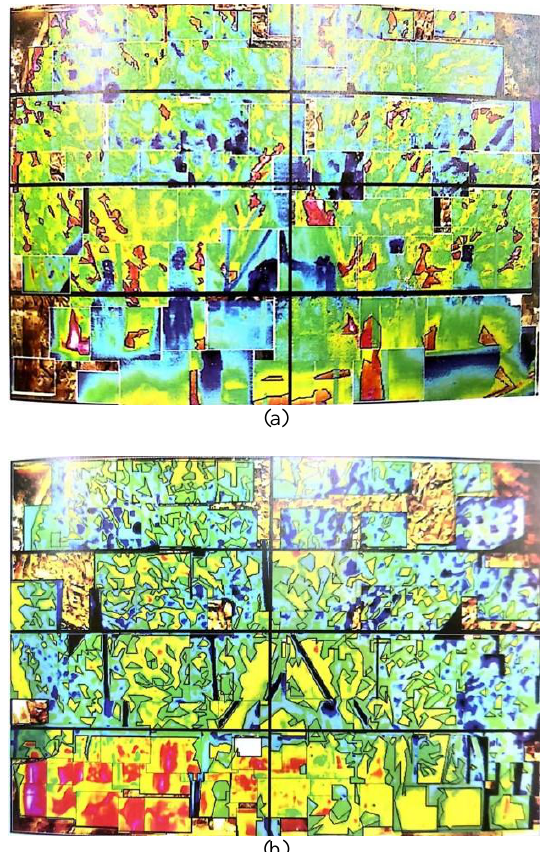
Figure 6 . The infrared images of the thousand-hand bodhisattva